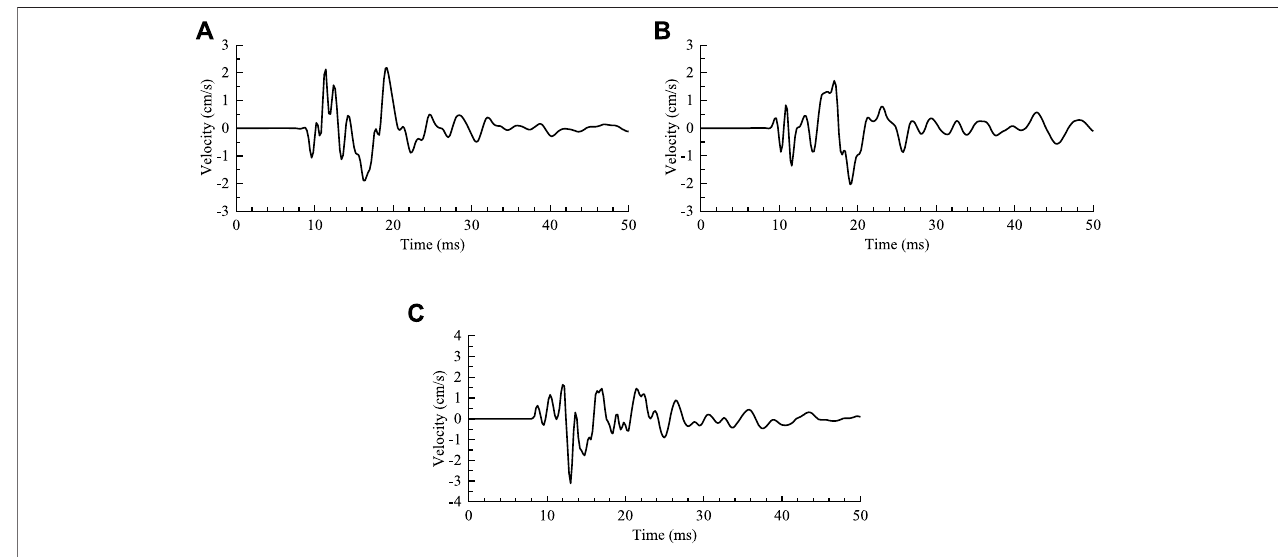
FIGURE 9 | Simulated vibration velocity histories caused by the combined actions of explosion loading and rapid stress release. (A) Transverse component, (B) Vertical component, (C) Longitudinal component (Yang J. et al., 2018).